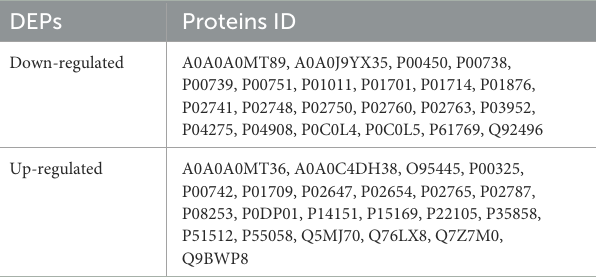
TABLE 4 44 differentially expressed proteins (DEPs) were identified in the study, including 22 up-regulated proteins and 22 down-regulated proteins in ischemic stroke before and after rehabilitation